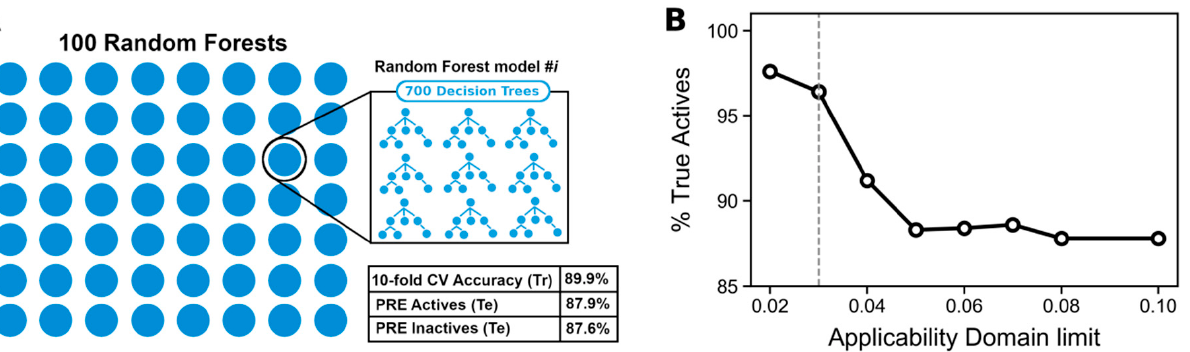
Figure 11. Chemical space distribution of training (blue) and test (cream) sets of the complete RIPK1 inhibitors dataset.